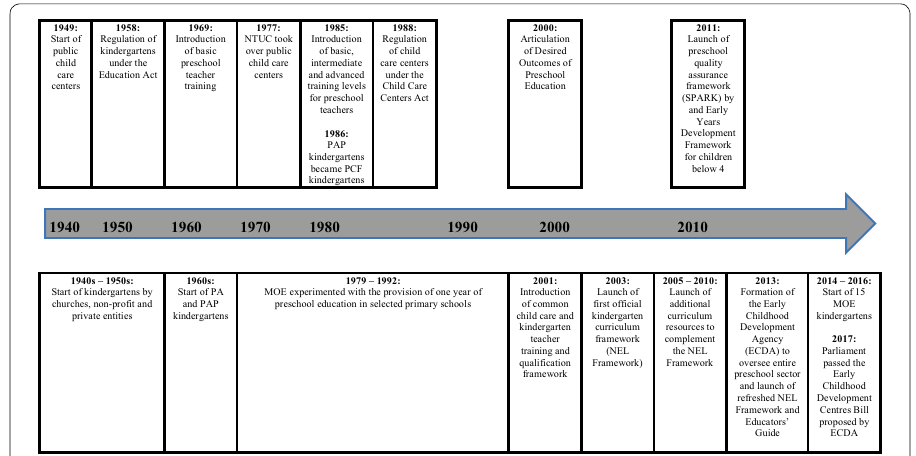
Fig. 1 Prominent milestones in Singapore’s preschool